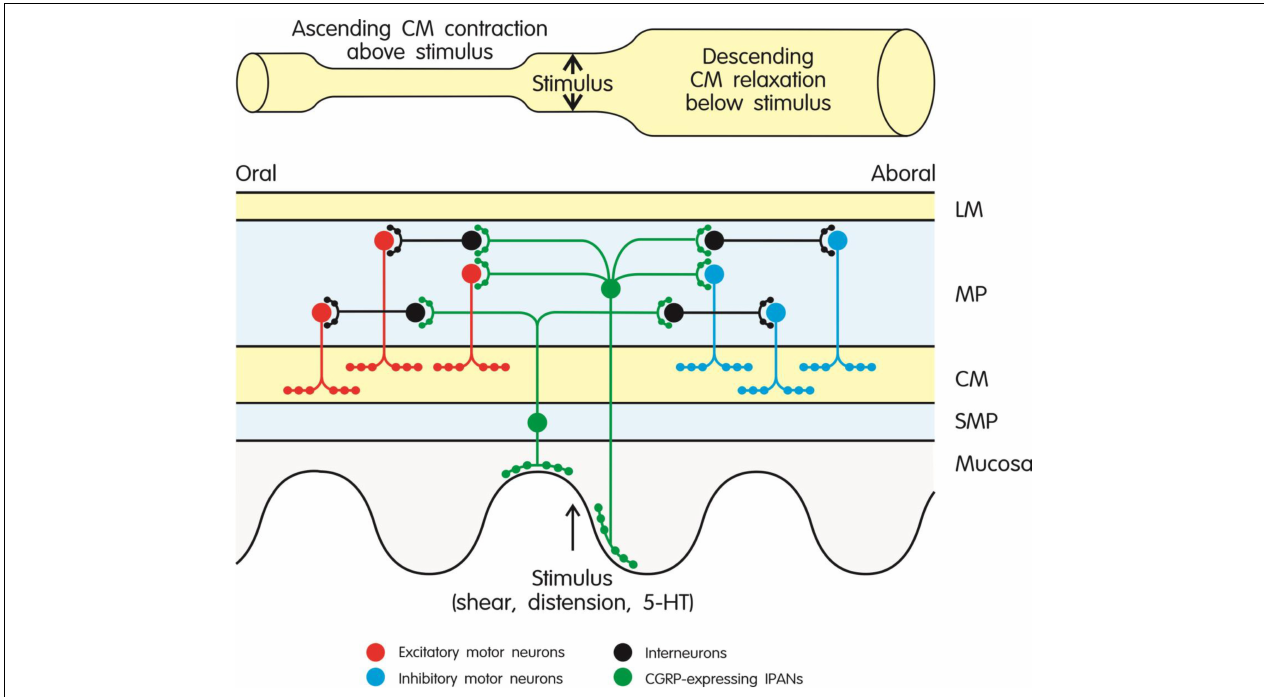
FIGURE 2 | Role of CGRP-expressing intrinsic primary afferent neurons (IPANs) in the peristaltic motor activity of the intestine through activation of ascending excitatory and descending inhibitory pathways in the enteric nerve plexus. CGRP-expressing IPANs are stimulated by mechanical or chemical stimulation of the mucosa and intestinal wall. Ascending contraction of the circular muscle above the stimulus is mediated by interneurons and excitatory cholinergic motor neurons, while descending relaxation of the circular muscle below the stimulus is brought about by interneurons and inhibitory motor neurons (expressing nitric oxide synthase and various relaxant mediators). The different types of neuron are depicted by different color codes as explained in the graph. The model shown in the graph takes particular account of the findings reported by Grider et al. (1998) and Smolilo et al. (2020). CM, circular muscle; 5-HT, 5-hydroxytryptamine; LM, longitudinal muscle; MP, myenteric plexus; SMP, submucosal